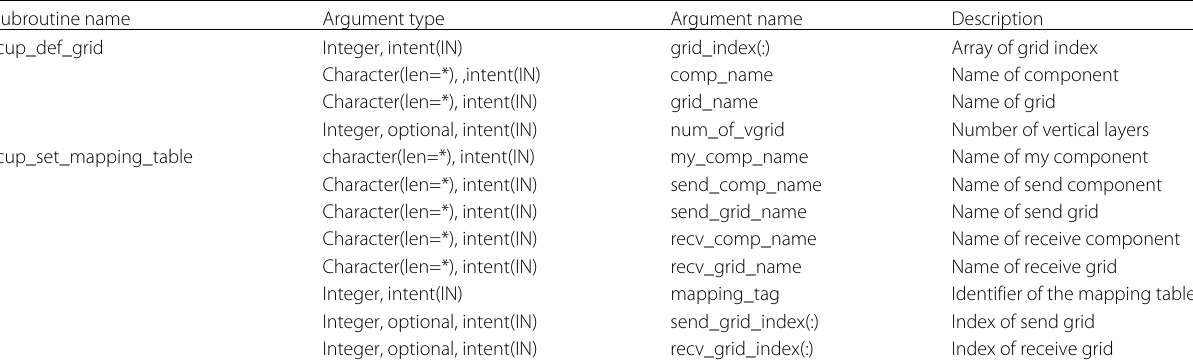
Table 1 APIs for grid setting